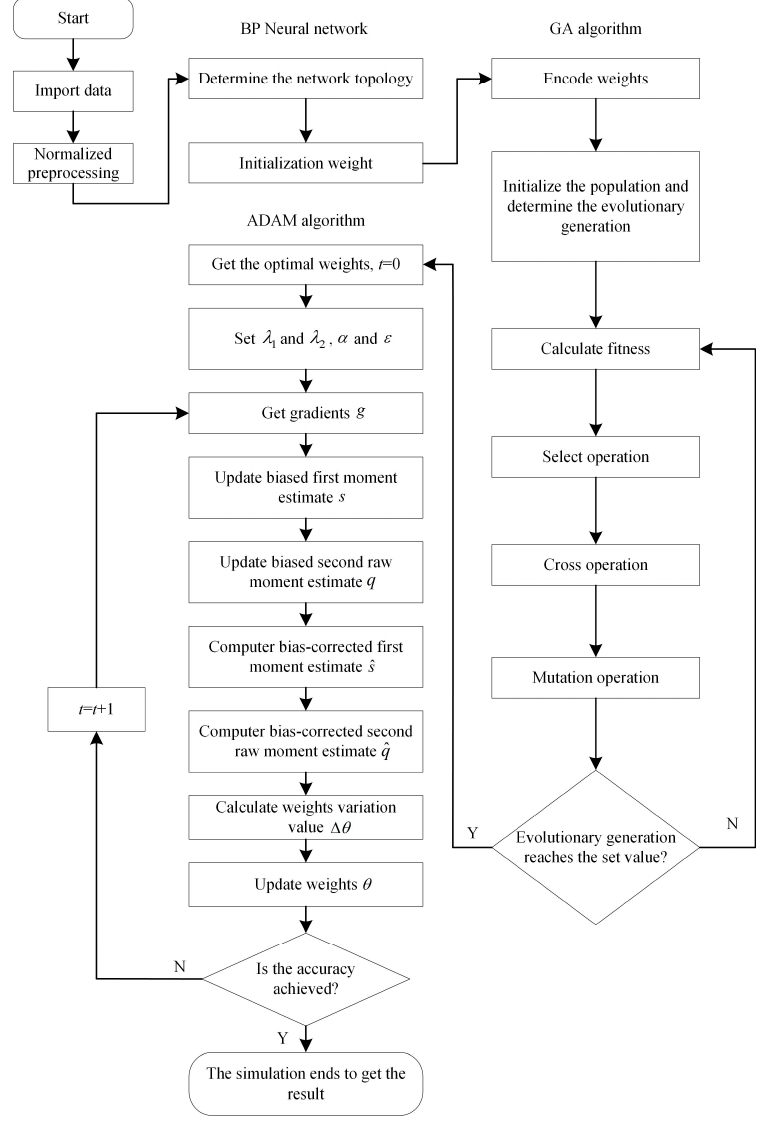
Figure 13. The process of applying genetic algorithm (GA) combined with Adam to BP neural network.